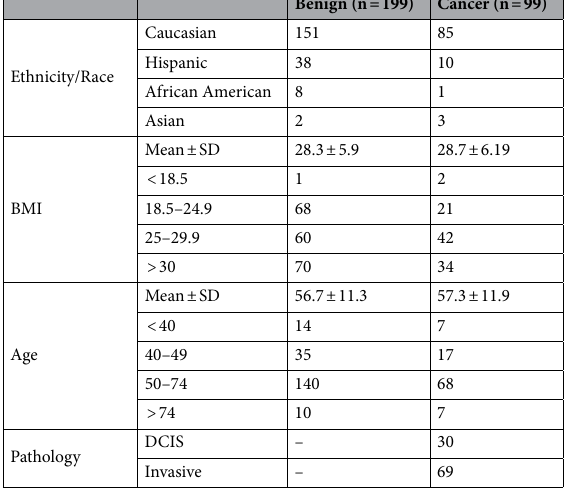
Table 1. Clinical characteristics of samples by diagnosis. BMI, body mass index; SD, standard deviation; DCIS, ductal carcinoma in